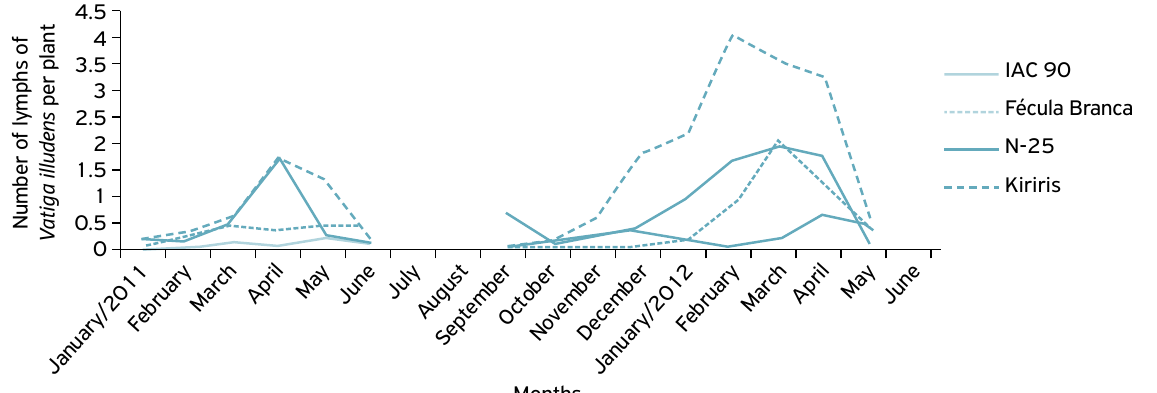
Figure 3. Mean population fluctuation of adults of Vatiga illudens (Hemiptera: Tingidae) in different cassava cultivars from January 2011 to June 2012, Dourados, Mato Grosso do Sul.